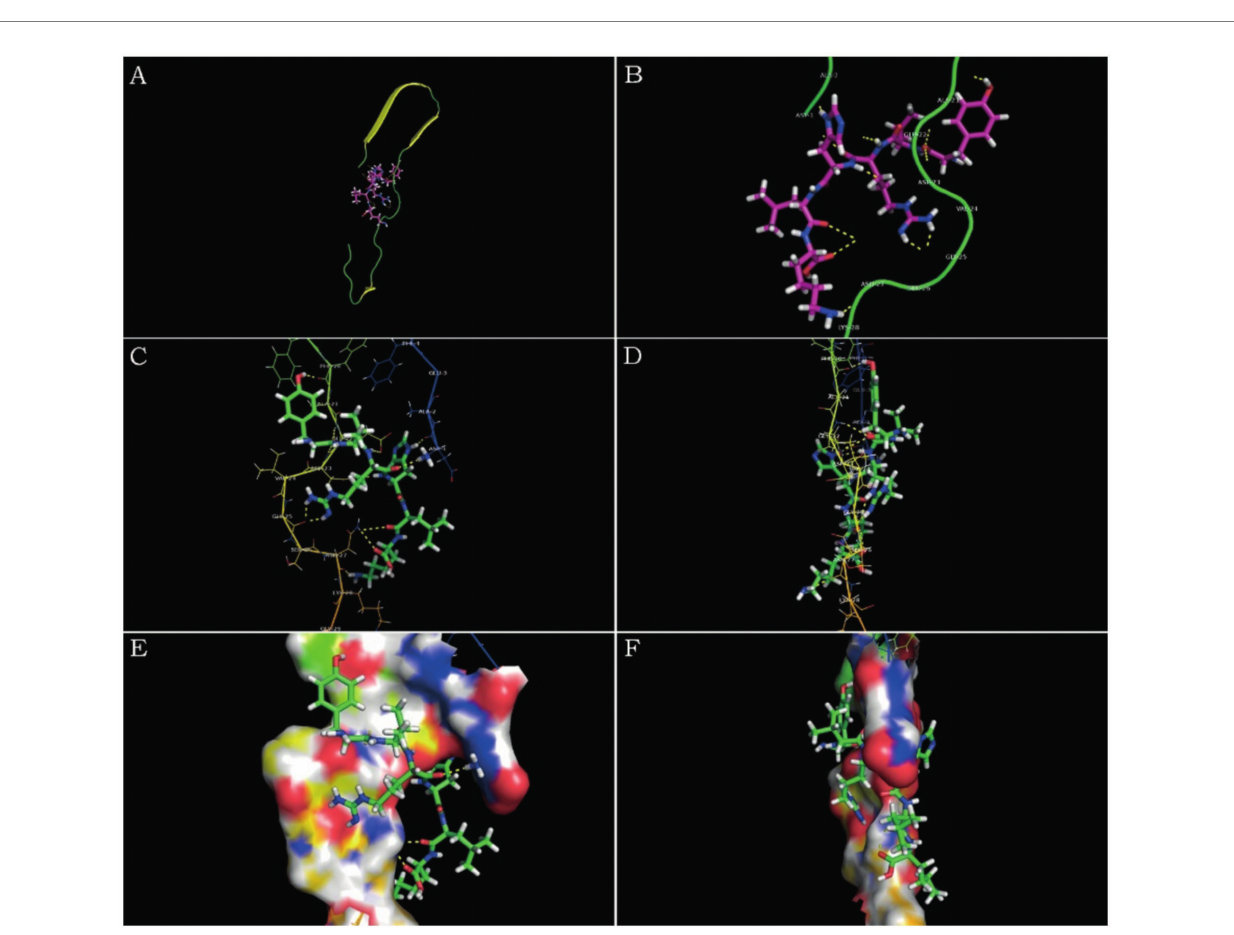
FIGURE 7 Schematic diagram of P21 and A β 1–42 protein binding. (A) The three-dimensional structure diagram of the combination of P21 and A β 1–42 is displayed as a whole. (B–F) Show the combination of P21 and A β 1–42 from different